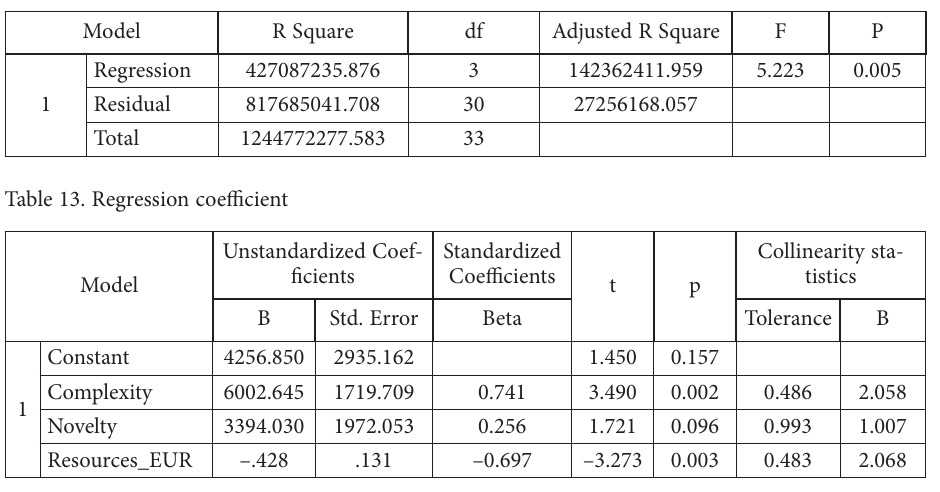
Table 12. ANOVA Regression